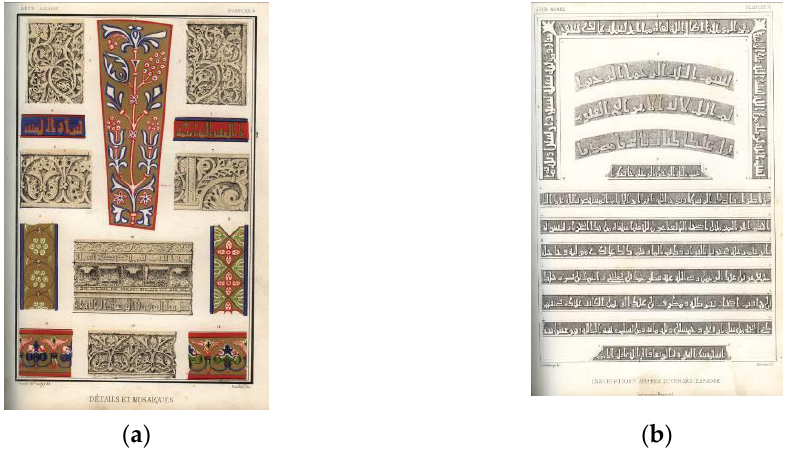
Figure 11. Girault de Prangey: ( a ) Details and mosaics (Dumouza, lit.); ( b ) Arabic inscriptions (Asselineau, lit.). Source: Essai sur l’architecture des Arabes et des Mores, en Espagne... 1841.